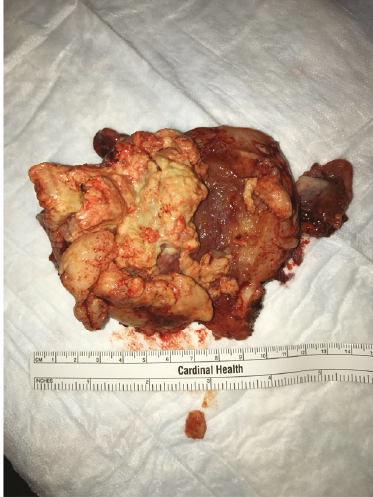
Figure 2: Gross specimen, bisected uterus and cervix, fallopian tubes, and ovaries, showing an exophytic, friable endometrial mass.